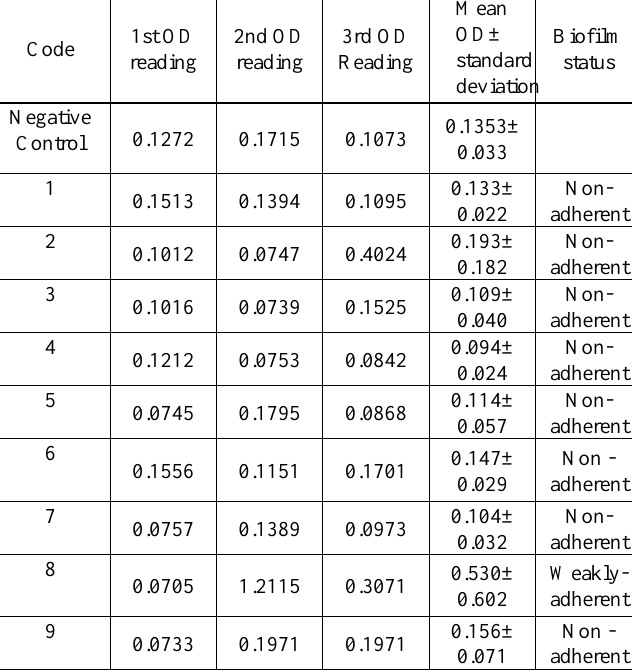
Table 4: Biofilm Formation Assay by TCP of